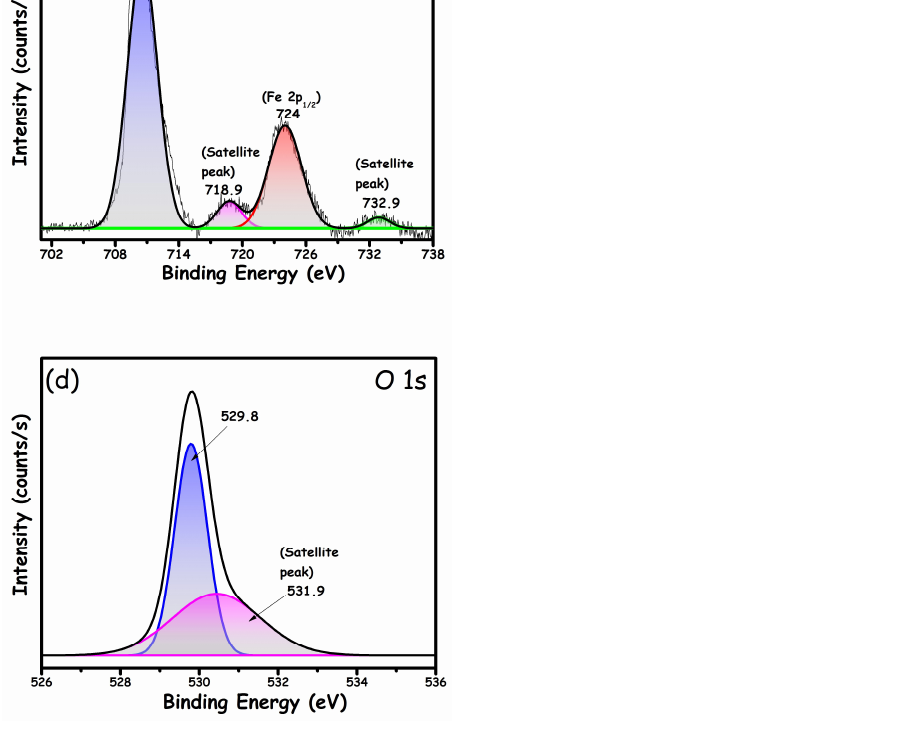
Figure 4. XPS spectra of g-C 3 N 4 / α -Fe 2 O 3 nanocomposite: ( a ) C (1s), ( b ) N (1s), ( c ) Fe (2p), and ( d ) O (1s).